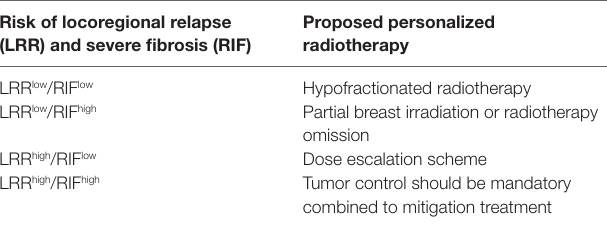
TABLe 2 | Proposed prospective clinical trials according to tumor control (LRR high or LRR low ) and normal tissue complications (RIF high or RIF low ) probability. Risk of locoregional relapse (LRR) and severe fibrosis